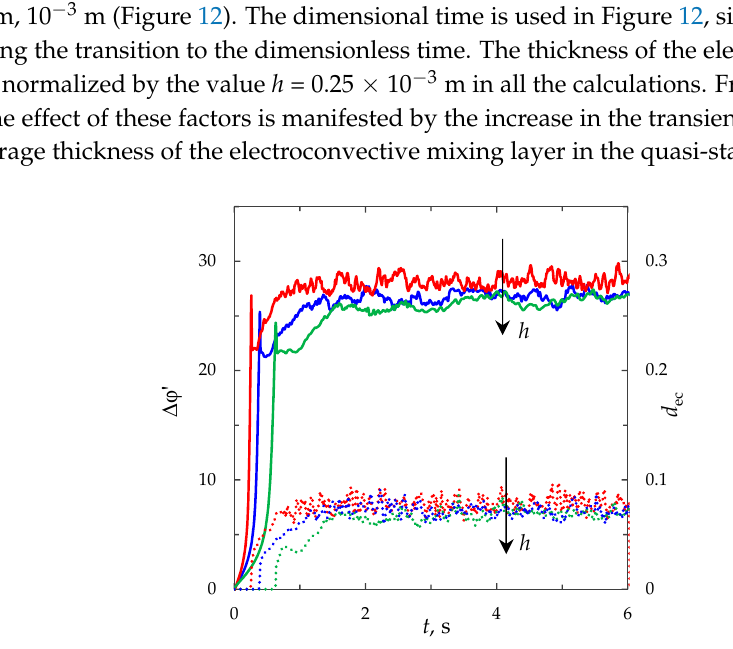
Figure 11. ChP (solid lines) and average thickness of the electroconvective mixing layer, d ec (dotted lines). The results of calculation for l = 4 (red lines), 8 (blue lines), 12 (green lines) at current density i av / i lim = 2.